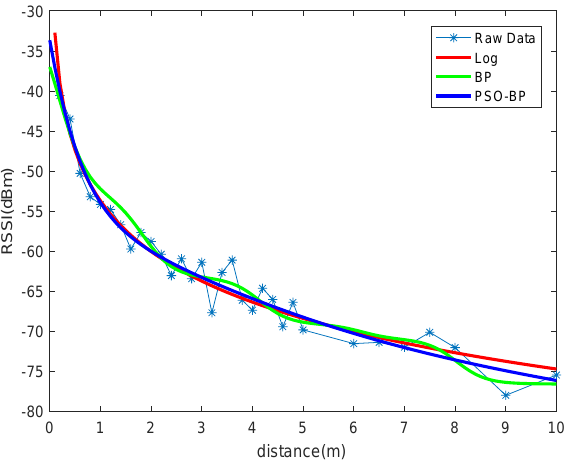
Figure 9. The result of RSSI distance model fitted by the logarithmic distance loss model, back propagation neural network (BPNN), and back propagation neural network optimized by particle swarm optimization